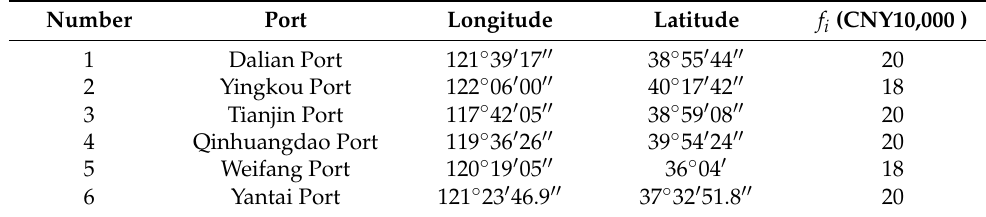
Table 3. Data of candidate shore-based emergency materials reserves.